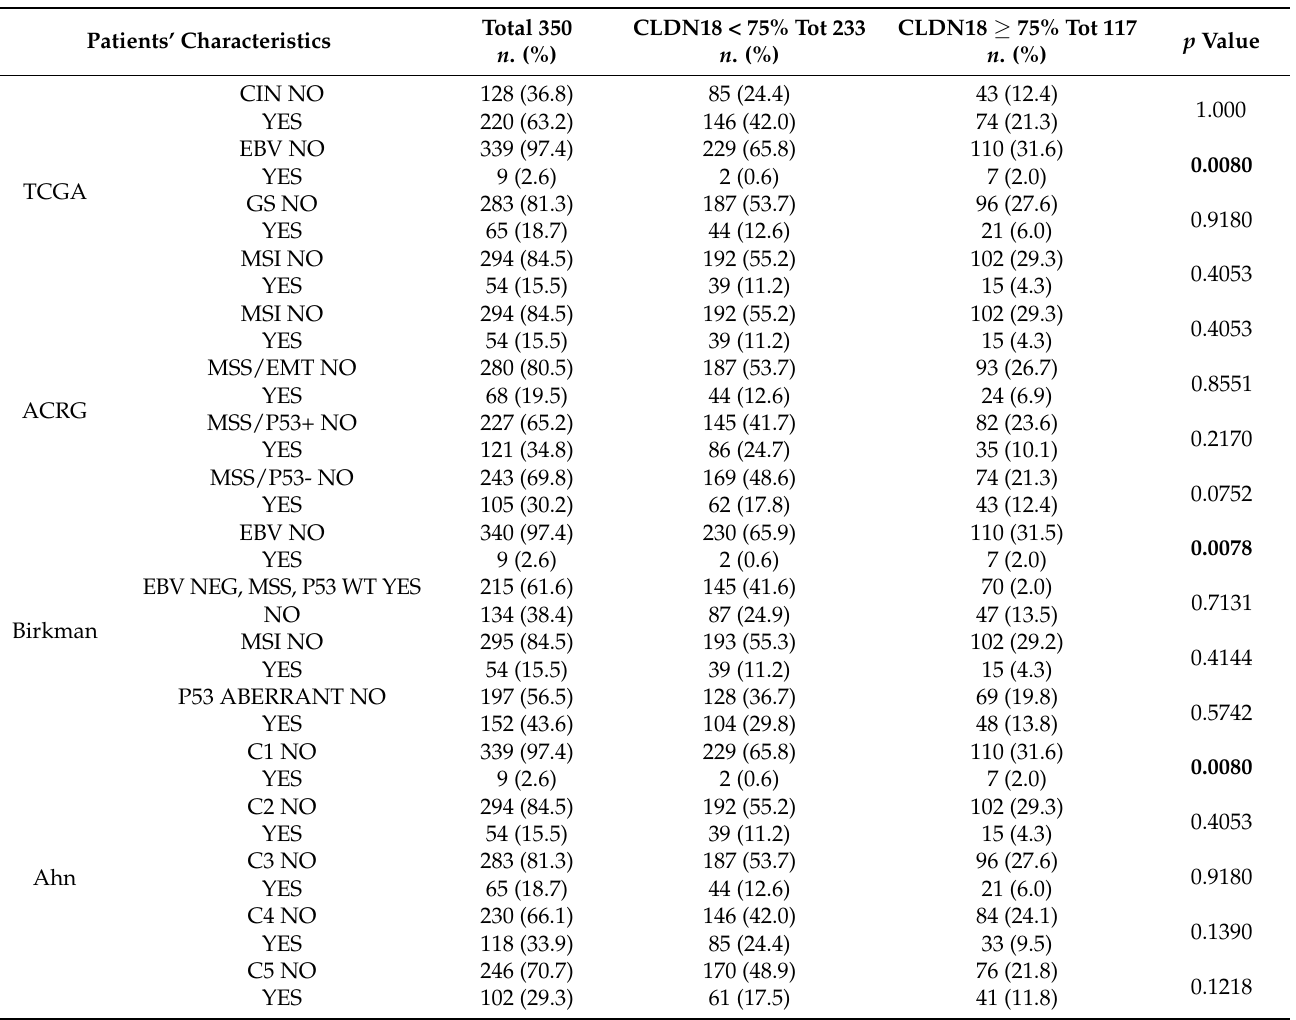
Table 3. Immunohistochemical molecular classification of the considered series according to CLDN18 status (note that the sum of patients does not add to 350 patients for all the parameters due to missing clinical data or exhausting tumor tissue). Total Patients’ Characteristics